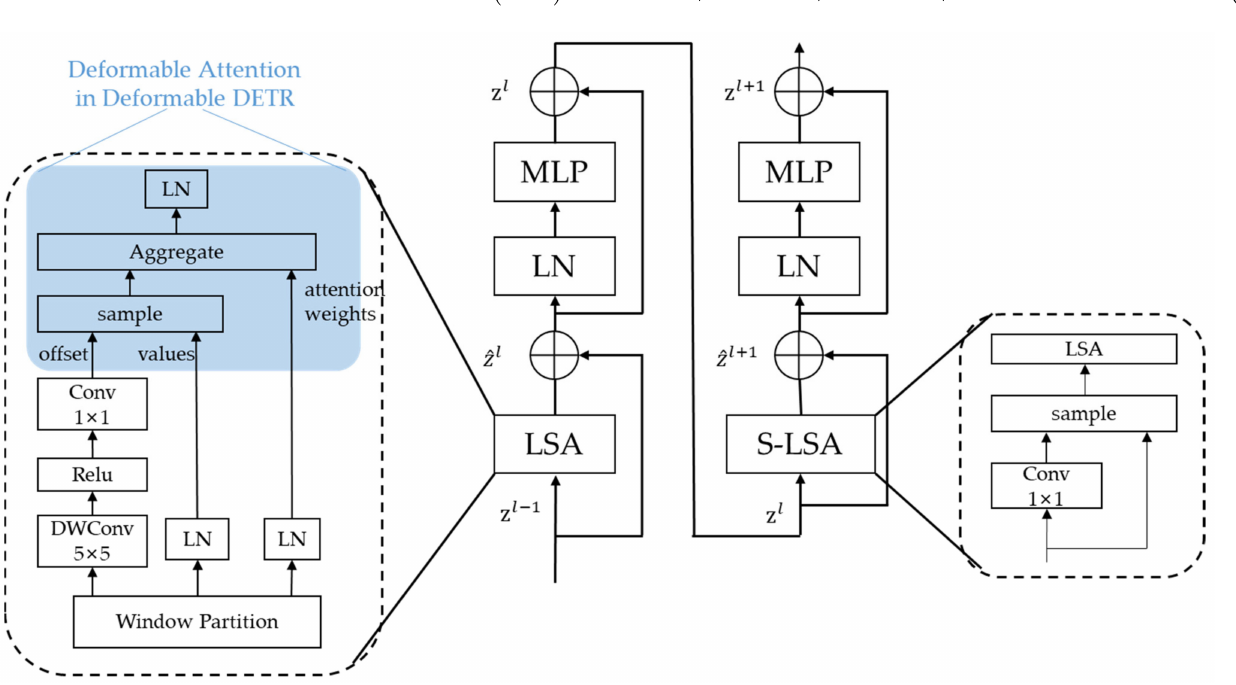
Figure 5. The structure of a local-sparse-information-aggregation